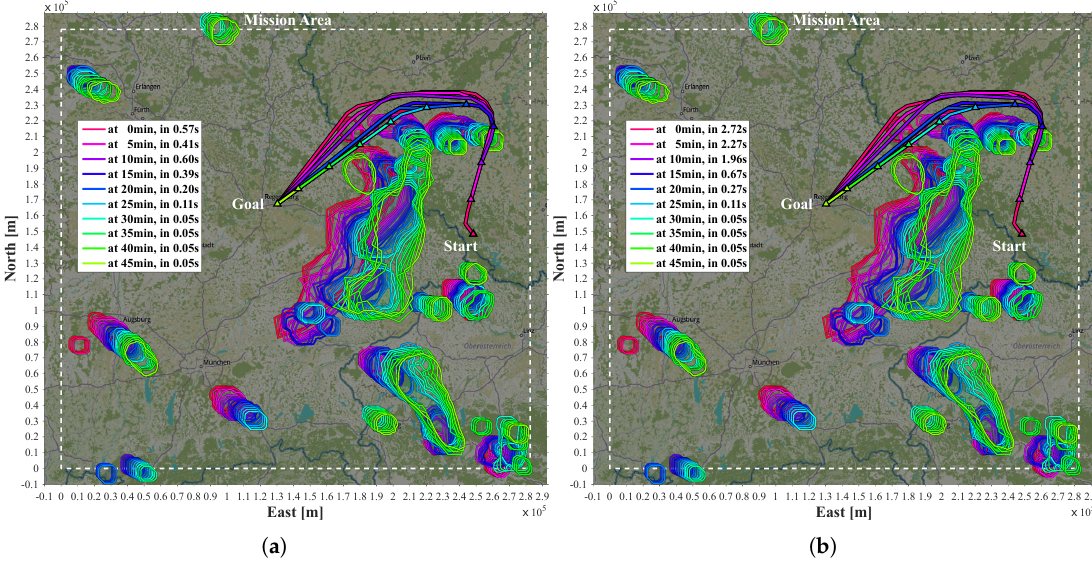
Figure 11. ( a ) Continuous avoidance using SSPH. ( b ) Continuous avoidance using EDH. The runtimes for the MPTP iterations are listed in the respective